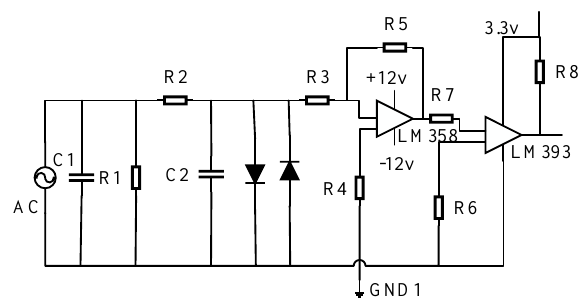
Figure 6. Rotor speed sensor conditioning circuit.